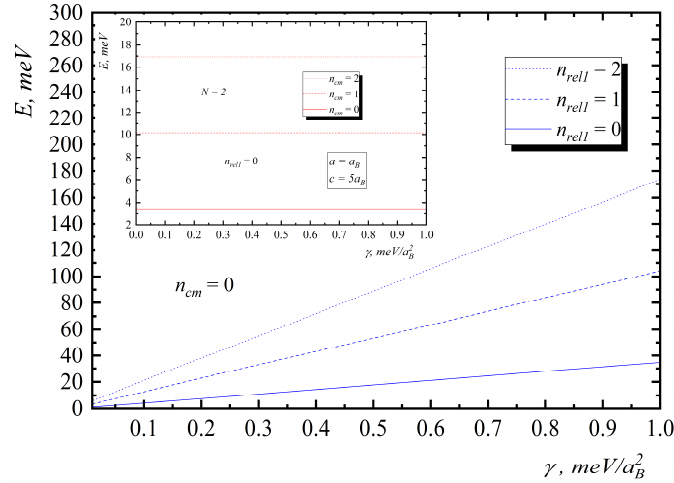
Figure 8. Dependences of the energies on the interaction parameter γ for relative motion (insert—center of mass motion).